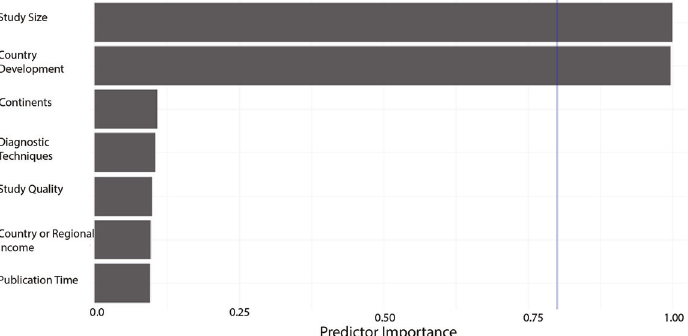
Fig. 4 Multi-variable meta-regression for postpartum depression prevalence. (Multi-variable meta-regression was performed in order to fi nd out factors with the highest predictor